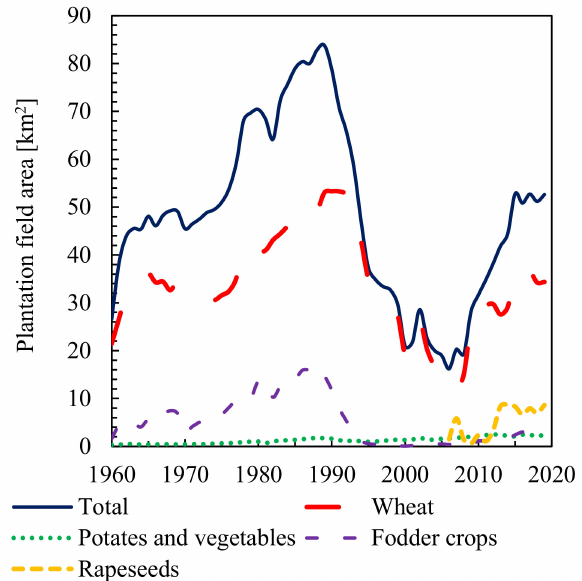
Figure 1. Changes in the field area of Mongolia from 1960 to 2019